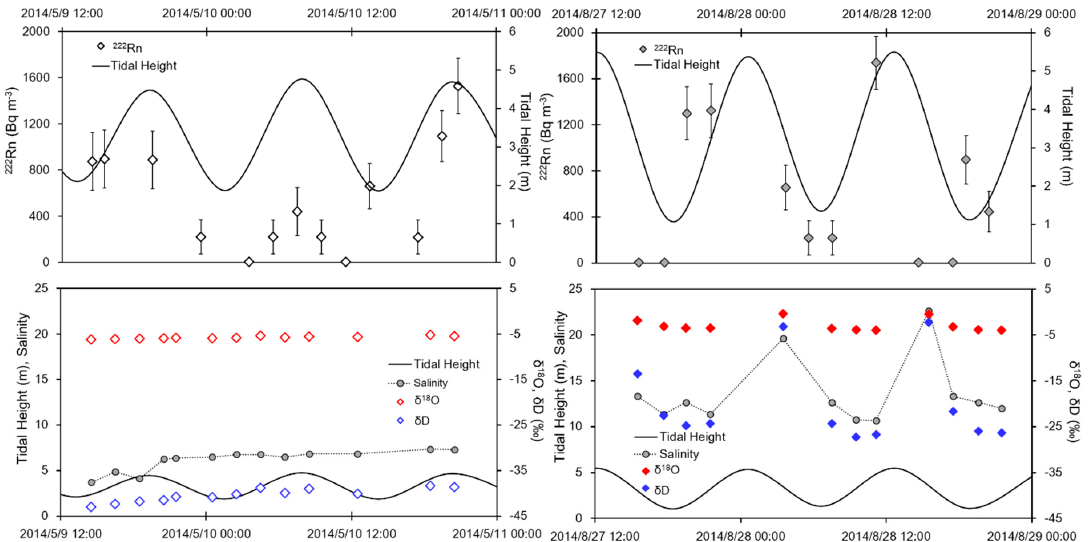
Figure 3. The plots show the temporal variations of salinity, of 222 Rn, δ 18 O, and δ D in the pore water samples collected from 35 cm below the seabed at the Gaomei Wetland (left: dry season, 9~10 May 2014; right: wet season, 27~28 August 2014) together with the tidal height.